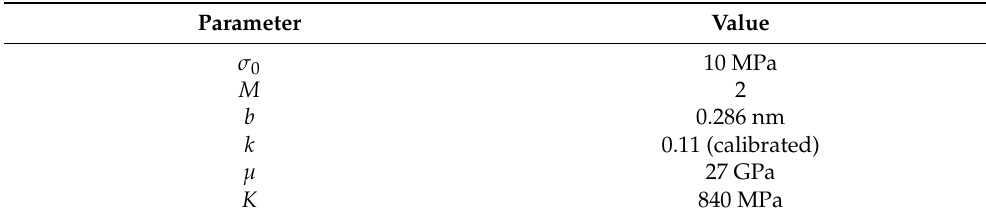
Table 4. Precipitate strength calculation formula related variables